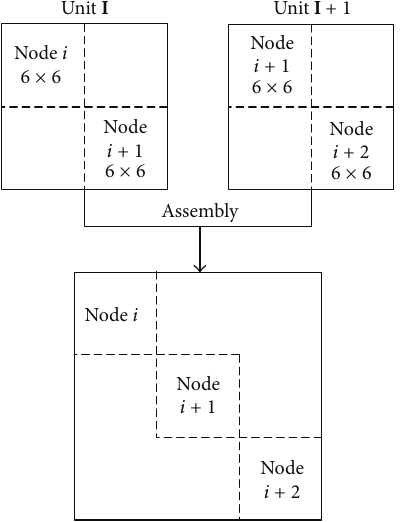
Figure 4: Schemes of adjacent unit assembly.